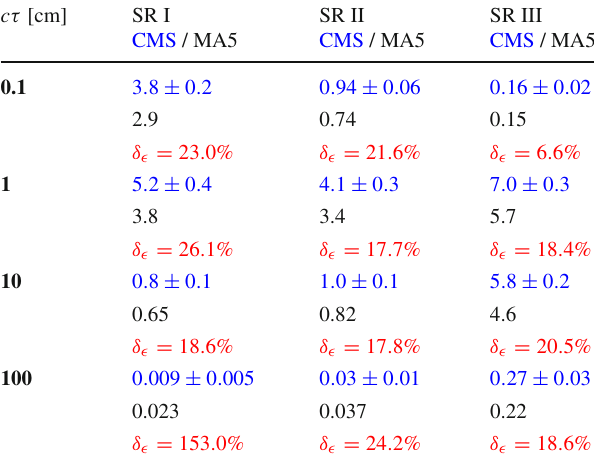
Table3 Expectednumberofeventspassingtheselectioncriteriadefin- ing each of the CMS-EXO-16-022 signal regions, as obtained with our SFS implementation (black). We compare our predictions with the offi- cial CMS results (blue), and show the relative deviation δ (cid:8) in the selec- tion efficiency (red)